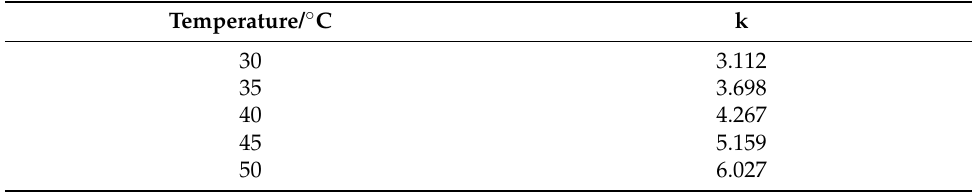
Table 1. k values at different reaction temperatures. Temperature/ ◦ C